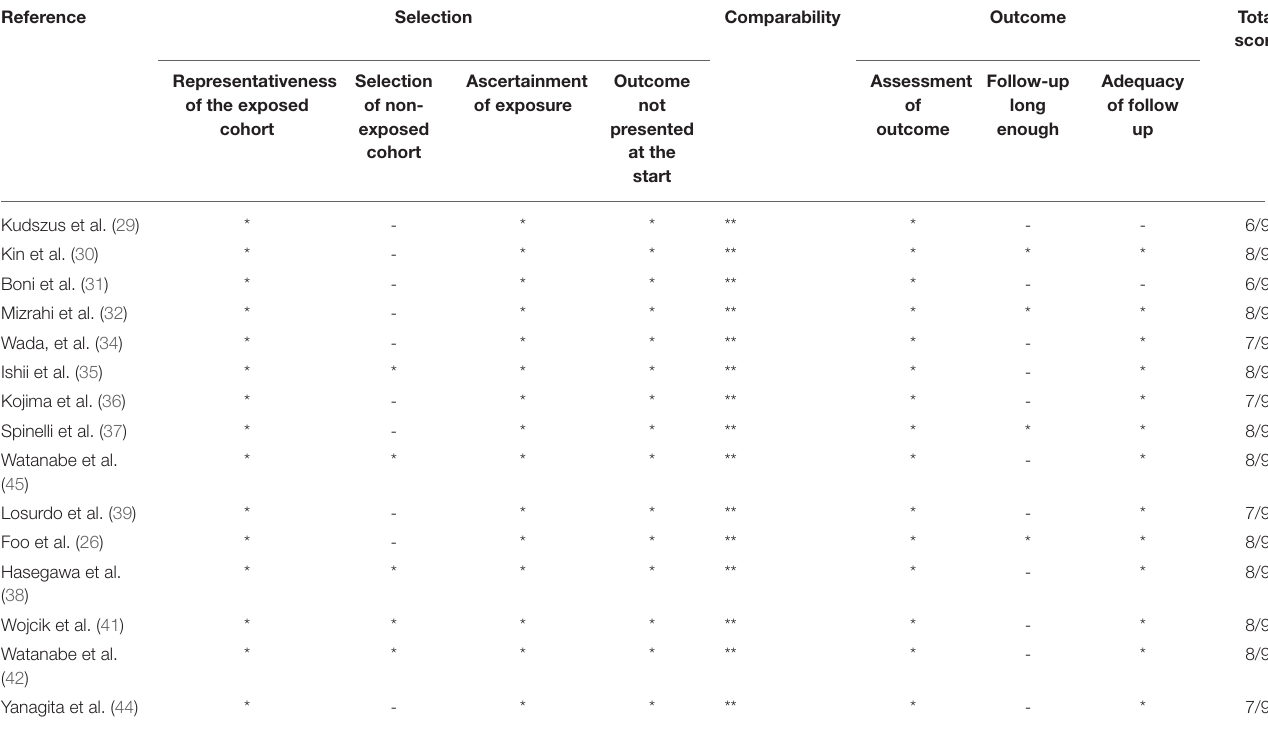
TABLE 2 | Outcome of assessment of the quality of non-randomized studies using the Newcastle-Ottawa scale. Reference Selection Comparability Outcome Total